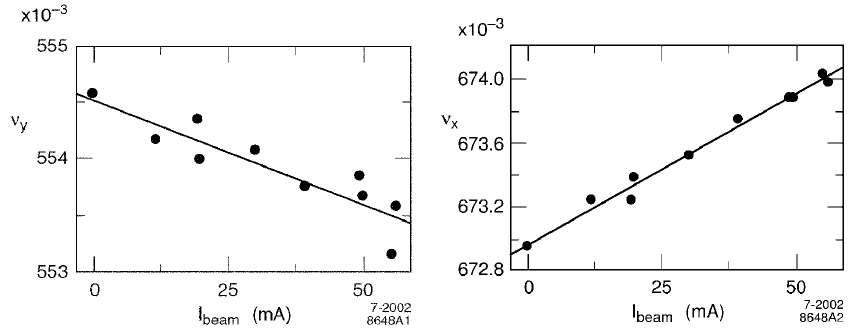
FIG. 1. The vertical (left panel) and horizontal (right panel) tune shifts with beam current in the PEP-II high energy ring. The vertical axis is the fractional part of the betatron tune, and the horizontal axis is the total beam current in mA. The nominal fractional part of the horizontal and vertical tunes are 0.618 and 0.638,